Question: Write a descriptive caption for this figure.
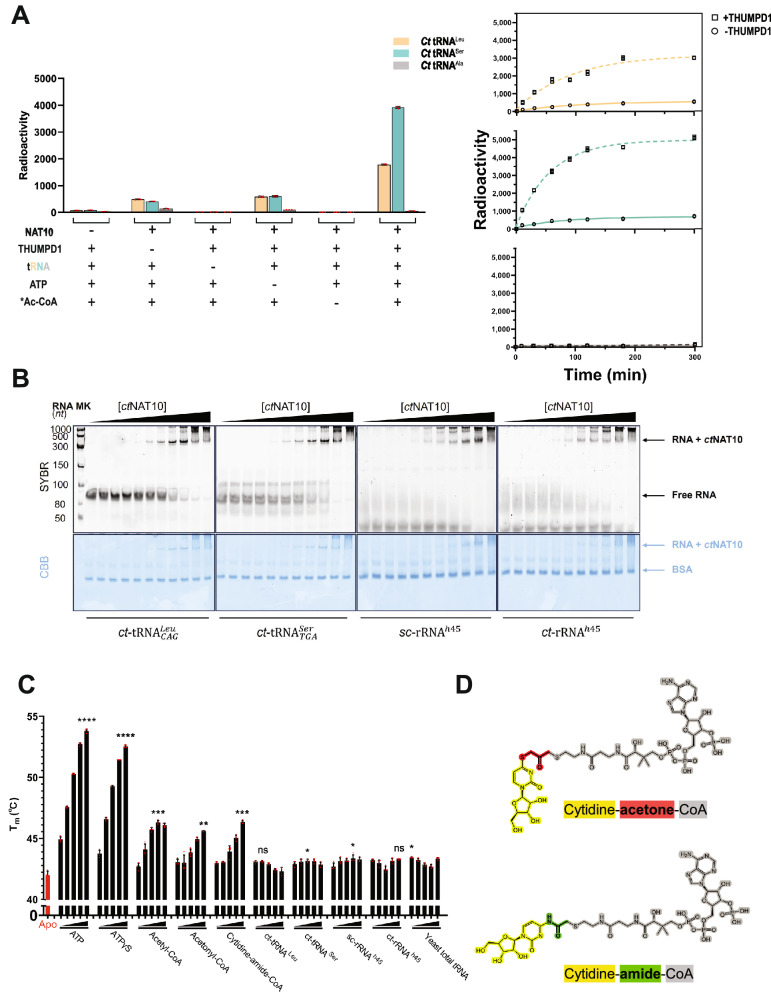
Answer: Biochemical characterization of recombinant NAT10 and cytidine-CoA probe compounds. A Radioactive acetylation assays to monitor incorporation of radiolabeled acetyl groups into the indicated tRNA substrates. Left panel – Endpoint assay with all or lacking components (“+” indicates added and “−” indicates not added). Reactions were incubated at 45 °C for 90 min. Right panels - Time course reactions carried out in the presence (+) or absence (-) of Ct THUMPD1 in the presence of cognate (tRNA Ser and tRNA Leu ) or non-cognate (tRNA Ala ) RNA. Radioactivity reflects the incorporation of the radiolabeled acetyl group over time. Data points represent the mean ± SD of 3 technical replicates, with individual data points overlaid as red dots. Source data are provided as a Source Data file. B Electrophoretic mobility shift assays of Ct NAT10 binding to tRNAs and rRNAs (6% polyacrylamide native gels) stained with SYBR™ Gold (upper panel) and Coomassie Brilliant Blue (lower panel) to visualize RNA and protein, respectively. The experiment was performed in a single replicate. RNA input was fixed at 5 pmol, and Ct NAT10 was titrated at 0, 0.2, 0.4, 0.7, 1.5, 3, 6, 11, 23, 45, 90 pmol (from left to right), with 0.2 mg/ml BSA added as a loading control and to prevent non-specific binding. RNA- Ct NAT10 complex, free RNA, and BSA bands are indicated with arrows. C Differential Scanning Fluorimetry of Ct NAT10 (1 μM) in the absence (red) and presence of substrates, metabolic ligands, non-hydrolyzable analogs, and cytidine-CoA probe (black). Ligands were evaluated from low to high concentration as follows: ATP, ATPɣS, Acetyl-CoA and acetonyl-CoA: 0.25, 2.5, 25, 250, 2500 μM; Cytidine-amide-CoA: 0.20, 2.0, 20, 200, 2000 μM; ct-tRNA Leu , ct-tRNA Ser , sc-rRNA h45 and ct-rRNA h45 : 0.625, 1.25, 2.5, 5, 10 μM; Yeast total RNA: 2.5, 5, 10, 20, 40 μM. Averaged values of three technical replicates with S.D. are shown. P -values are indicated for the melting temperature of each ligand at the